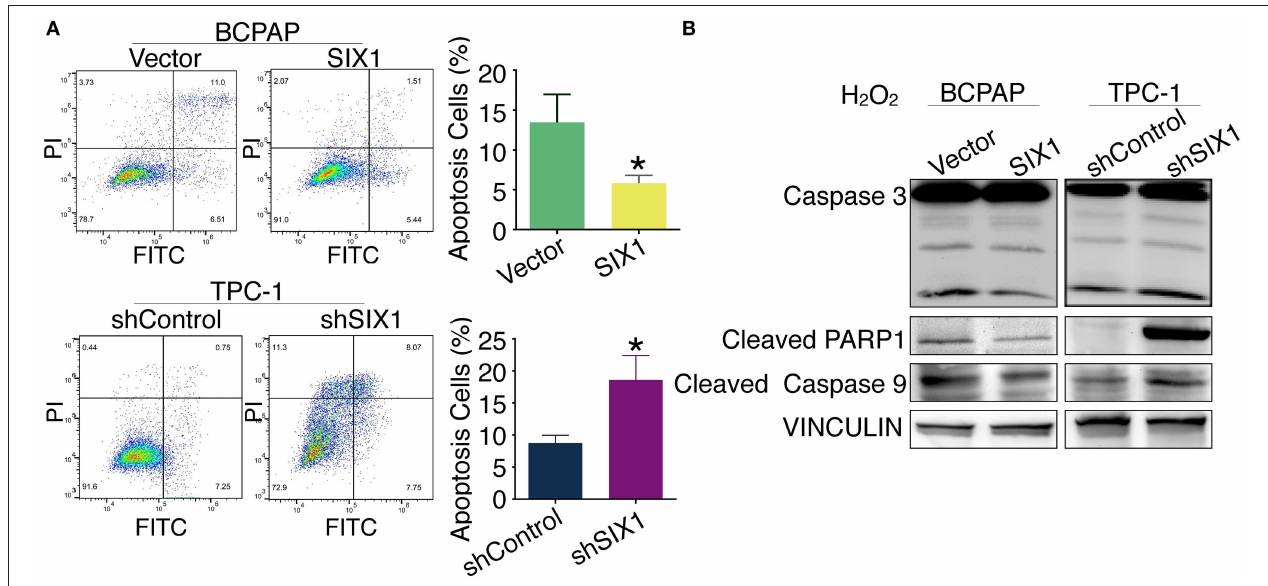
FIGURE 4 | SIX1 attenuated H 2 O 2 -induced apoptosis in PTC cell lines. PTC cell lines were incubated for 24h, and then exposed to 200 µ M H 2 O 2 for 24h. Annexin V-FITC/PI assay was used to evaluate the apoptosis. Representative image of apoptosis assay and quantitative analysis ( n = 3) (A) . The protein expression of caspase 3, cleaved PARP1 and cleaved caspase 9 in PTC cell lines was detected by Western blotting (B) . * p <